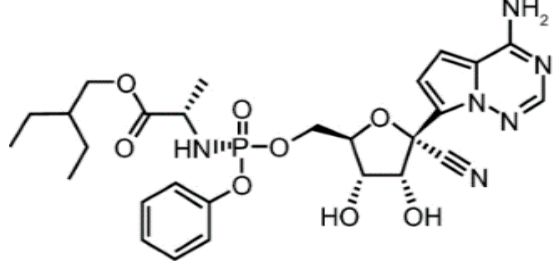
Figure 1. Chemical structure of RDS.